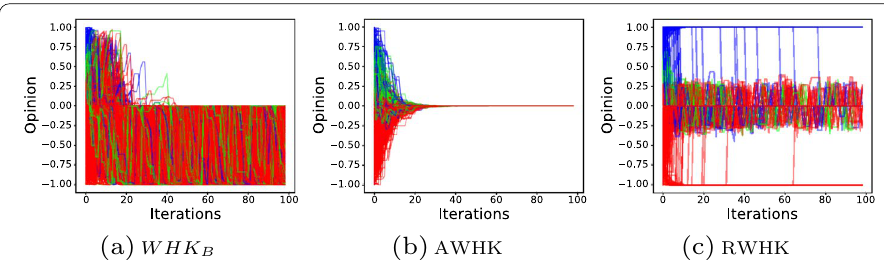
Fig. 4 Opinion evolution for the models with pair-wise interactions with ǫ equal 0.85. The system does not reach an equilibrium with the WHK B and the RWHK model